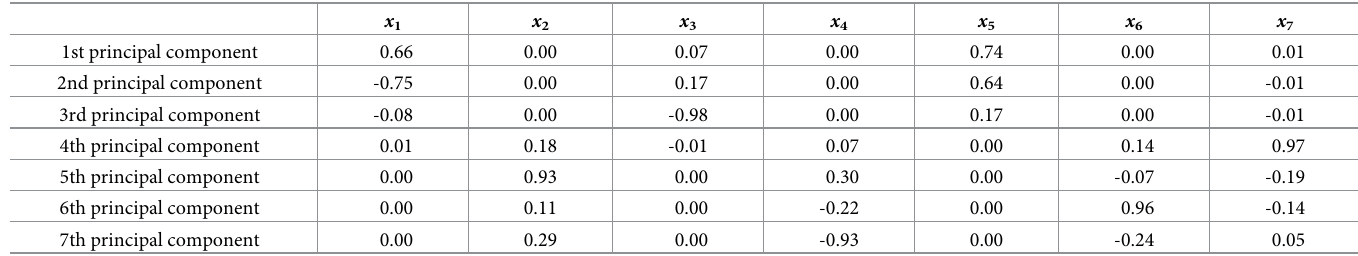
Table 4. Eigenvectors of principal components.